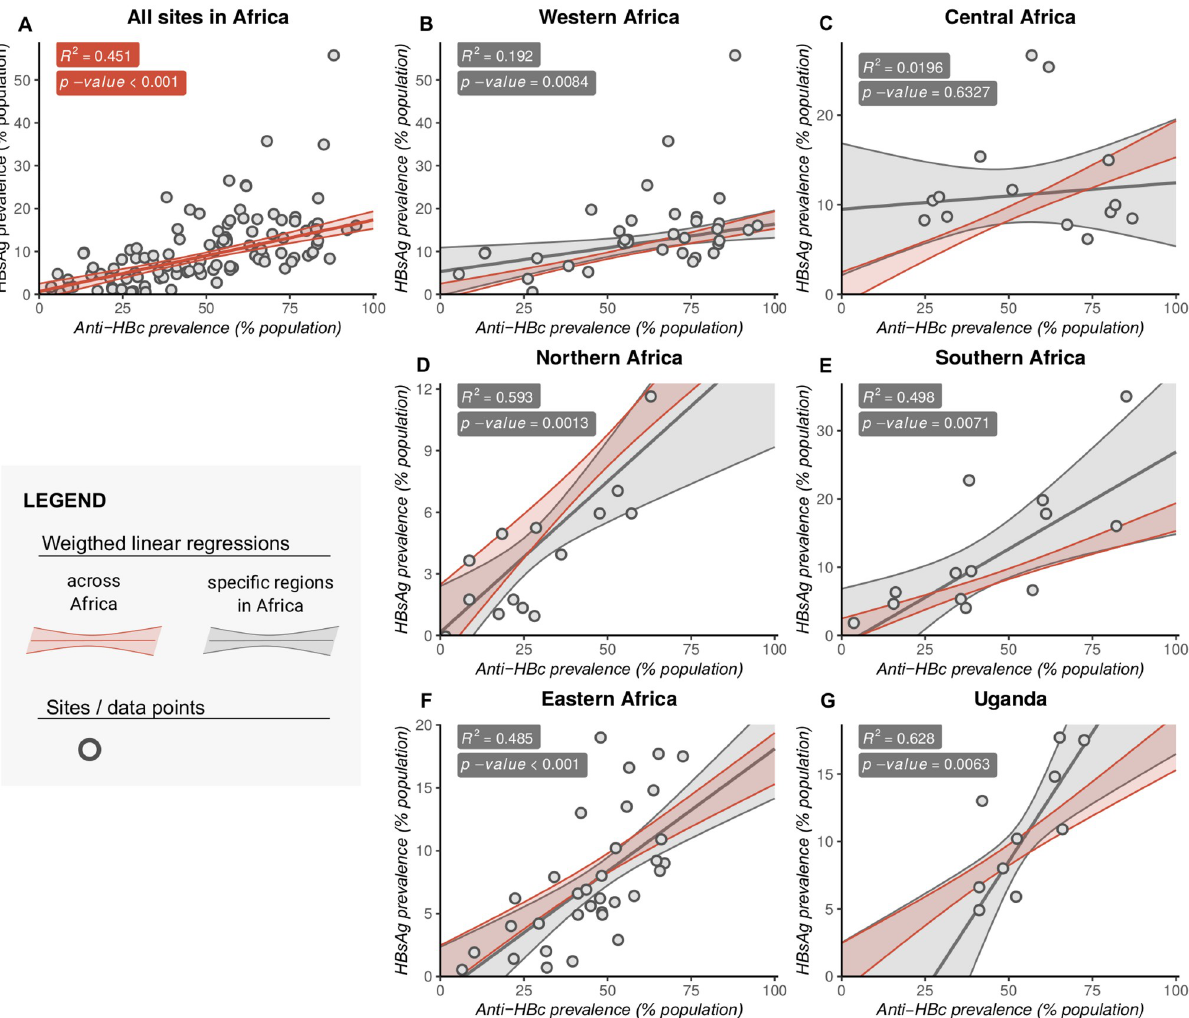
Fig 4. Relationship between population prevalence of anti-HBc (exposure) and HBsAg (active infection) for different regions of Africa. Data are shown for (A) the entire African continent; for (B) Western, (C) Central, (D) Northern, (E) Southern, and (F) Eastern Africa; and for (G) Uganda. These data are derived from a review of the published literature, using UN geoschemes to classify the geographic regions [24]. R 2 and p -values by weighted linear regression (solid line), with studies weighted by cohort size. Outer dashed lines show 95% confidence intervals. Weighted linear regression plots and 95% CIs (shaded regions) are shown for the whole of Africa in red, for each region in grey. Linear regression lines of fit in plots B– G have been shown together with the fit for the whole continent for comparison. In each plot, the dots represent only studies associated with that region. Anti-HBc, antibody to hepatitis B core antigen; HBsAg, hepatitis B surface antigen; UN, United